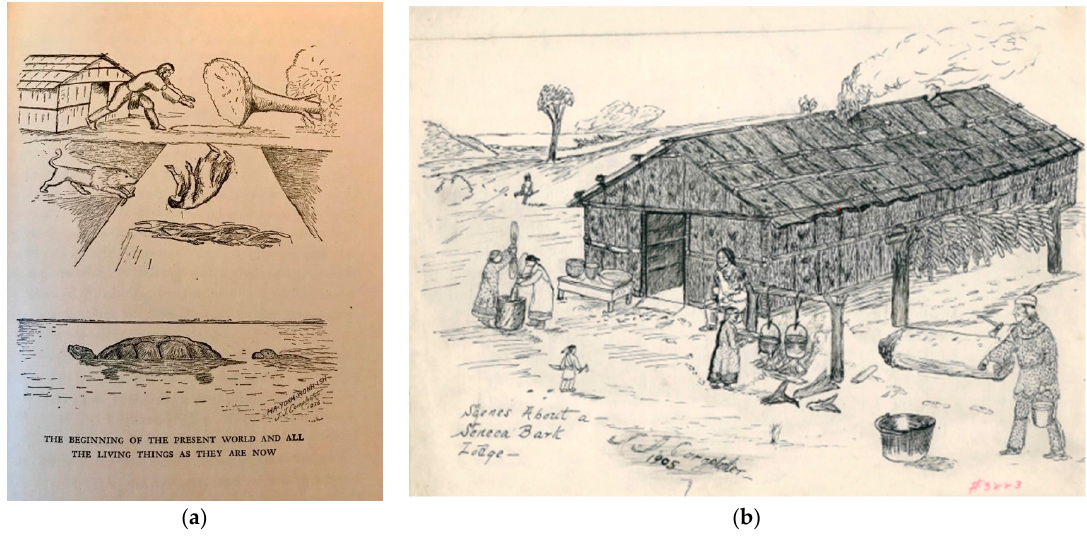
Figure 6. ( a ) Jesse Cornplanter illustration to Tales of the Longhouse , 1938. ( b ) Jesse Cornplanter drawing from 1905 used by Arthur Parker as illustration in 1923. Public domain.